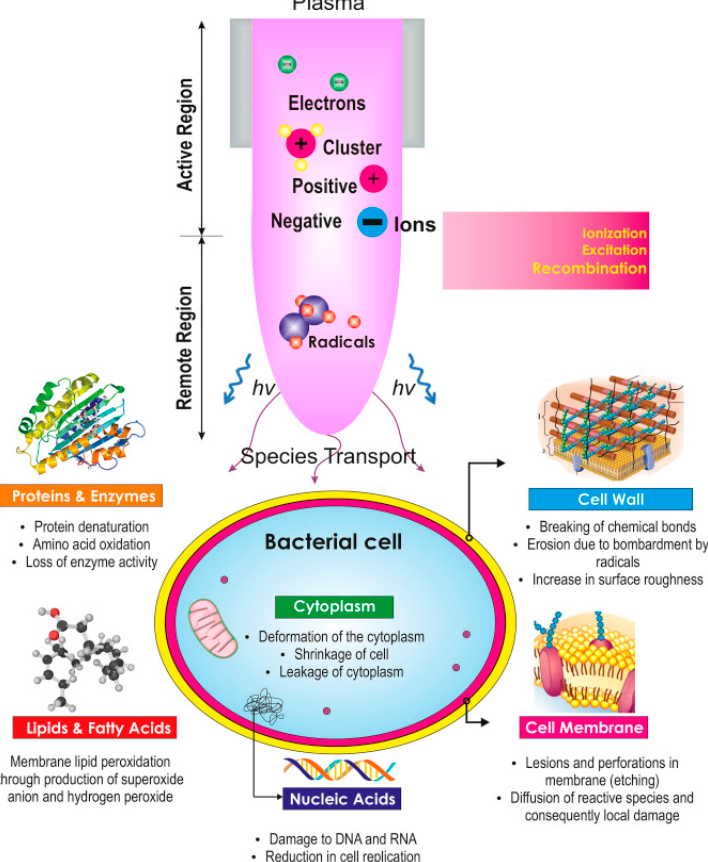
Figure 7. Action of NTAPP on bacterial sterilization (reprinted from [97], Copyright Elsevier (2017)).